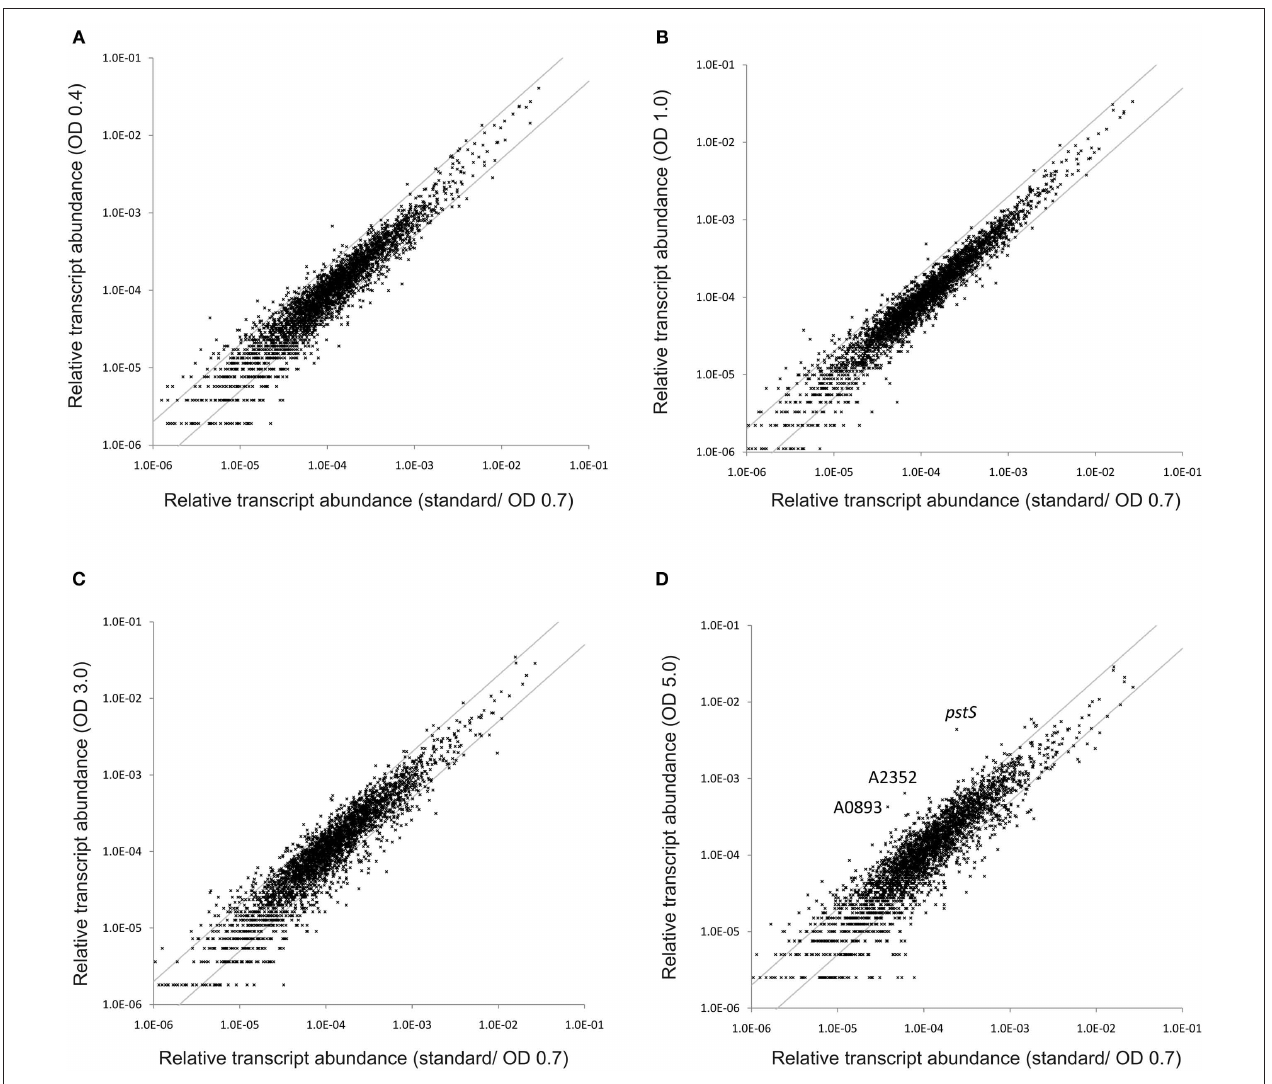
Figure 8 | Changes in the relative transcript abundance throughout standard batch growth. The scatter plots show the relative transcript abundances (A) at OD